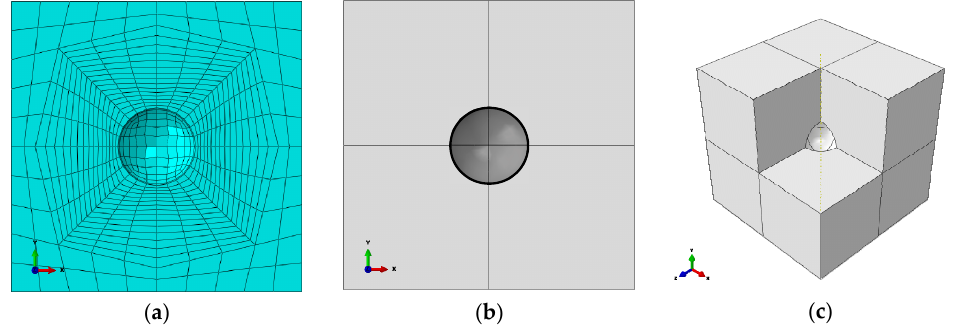
Figure 3. ( a ) finite element model for an RVE analysis in X–Y plane; ( b ) cell division for a void crossing the grain boundary or triple junction; ( c ) 3D view of the RVE cell with a void inclusion.